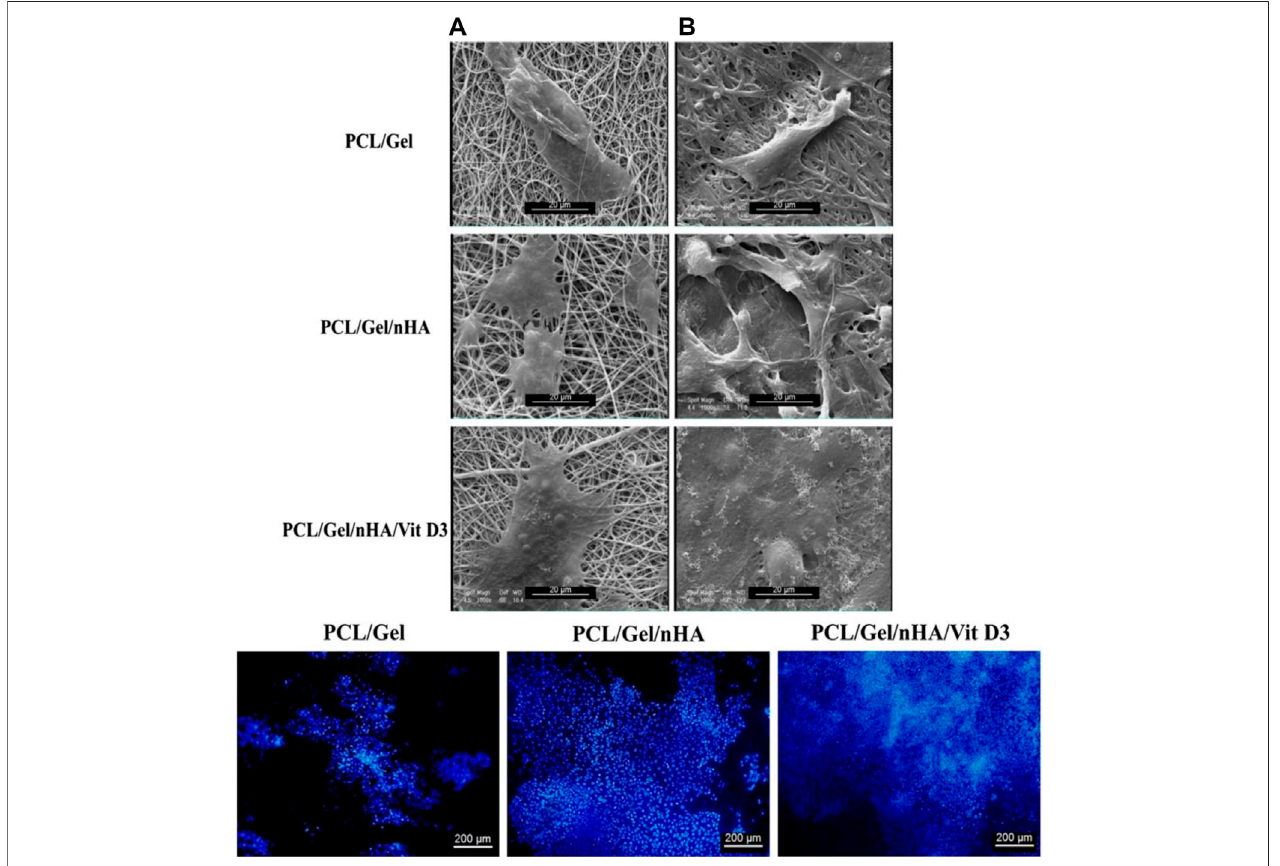
FIGURE 6 | Upper row: SEM images imply the adhesion of MG-63 cells onto PCL/Gel nano fi bers with or without hydroxyapatite nanoparticles (nHA) and Vitamin D3 (Vit D3) after 1 (A) and 7 (B) days cell culture. Lower row: Fluorescence images of the DAPI stained MG-63 cells on the PCL/Gel nano fi bers with or without hydroxyapatite nanoparticles (nHA) and Vitamin D3 (Vit D3) after 7 days cell culture. Reproduced with permission. (Sattary et al., 2018), Copyright 2017, Wiley.